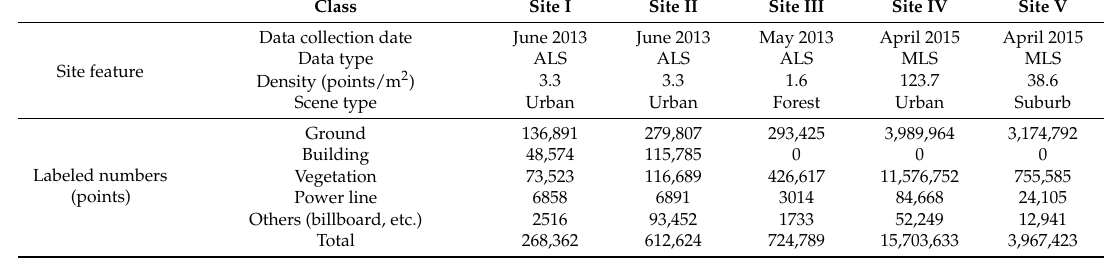
Table 1. Overview of five research sites (ALS = airborne laser scanning, MLS = mobile laser scanning).